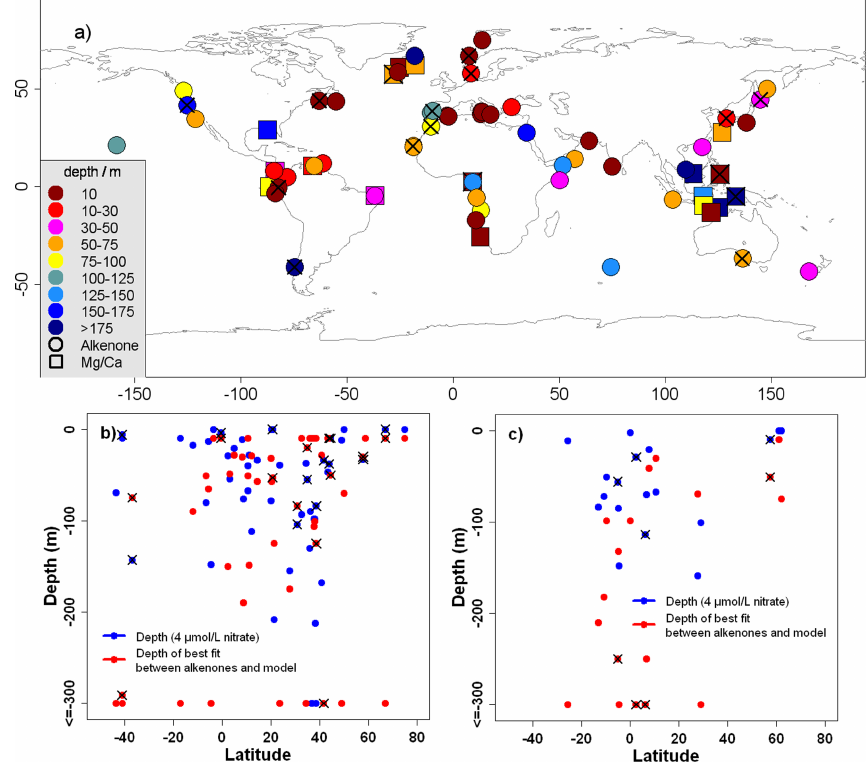
Fig. 11. (a) Depth for best agreement between alkenone and Mg/Ca temperature reconstructions and model simulation. The filled cir- cles/squares indicate the depth interval in which the best fit falls. (b) Depth of best fit between alkenone and model temperature trend (red dots) and depth where nitrate concentration is 4µmolL − 1 (blue dots). (c) As (b) , but for Mg/Ca-based temperature trends. The number of points may not be identical because of missing values or the values are out of range in the vertical. Crosses in indicate the record locations where the test of the regression residuals fails to show